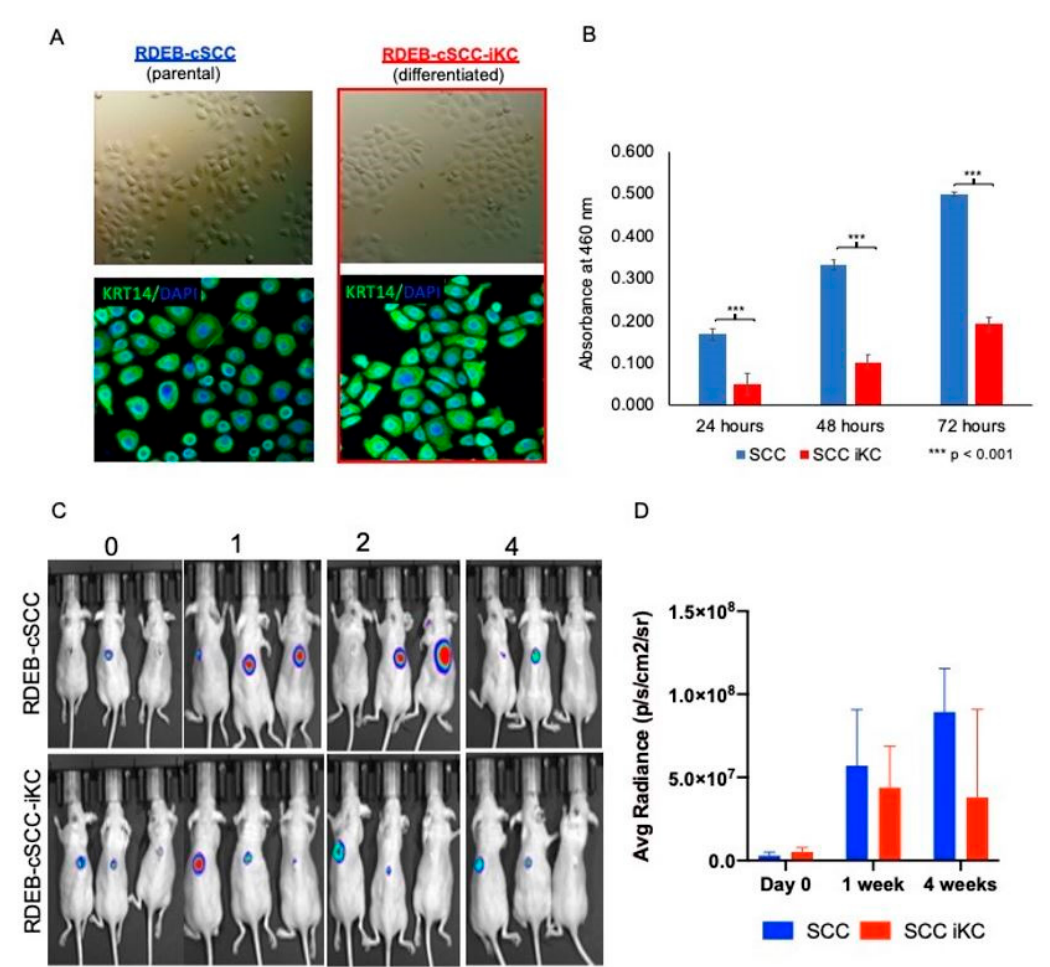
Figure 3. In vitro and in vivo characterization of RDEB-cSCC-iKC. ( A ) Representative pictures showing the morphological differences between parental RDEB-SCC and re-differentiated RDEB-cSCC-iKC. Keratin 14 (KRT14) is shown in green and nuclei are stained in blue (DAPI) on the representative immunofluorescence pictures. ( B ) RDEB-cSCC and RDEB-cSCC-iKC cell numbers over 72 h on absorbance at 490 nm measured using the CellTiter 96 ® AQueous Assay. *** p < 0.001 ( C ) Bioluminescence signal intensities over a 4-week course for tumor models derived from RDEB-cSCC and RDEB-cSCC-iKC. ( D ) Average radiance over a 4-week course for RDEB-cSCC and RDEB-cSCC-iKC tumor models.